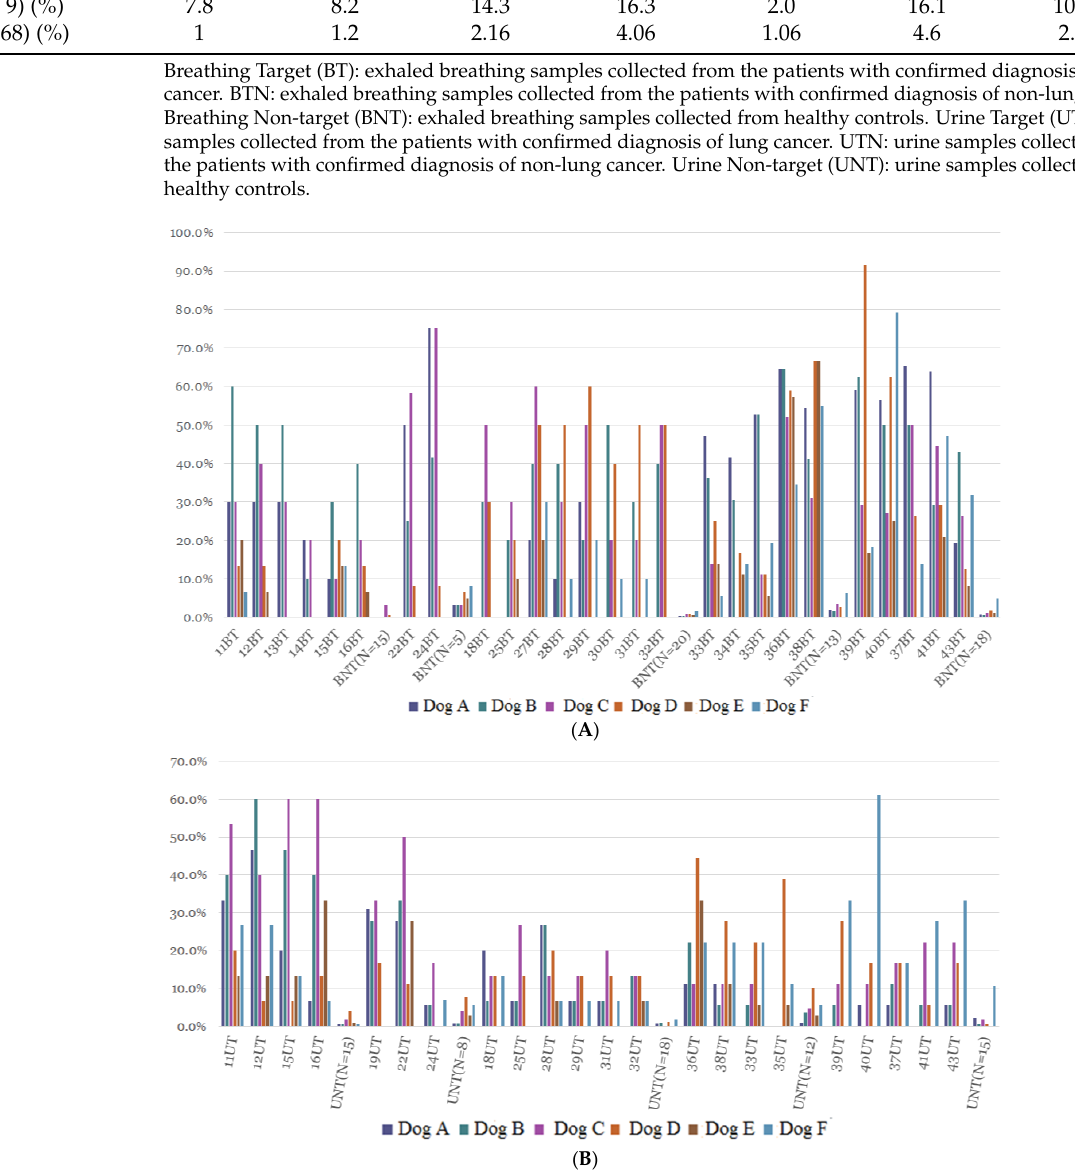
Table 2. The individual and total average lung cancer diagnostic rate of six dogs using lung cancer samples training and then the recognition of exhaled gases and urine samples in lung cancer and non-lung cancer patients groups was compared in the second stage training.